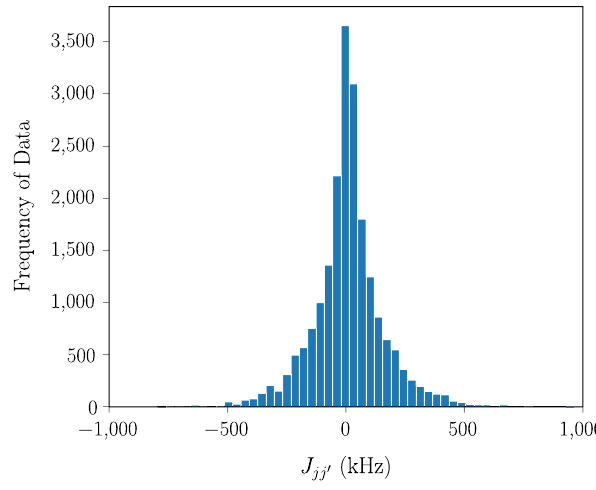
8. Histogram of spin-spin coupling terms when the beat is tuned slightly away from the COM note frequency μ R − ω 2 π × 0 . 5 frequency of the axial branch. Here, μ R z ¼